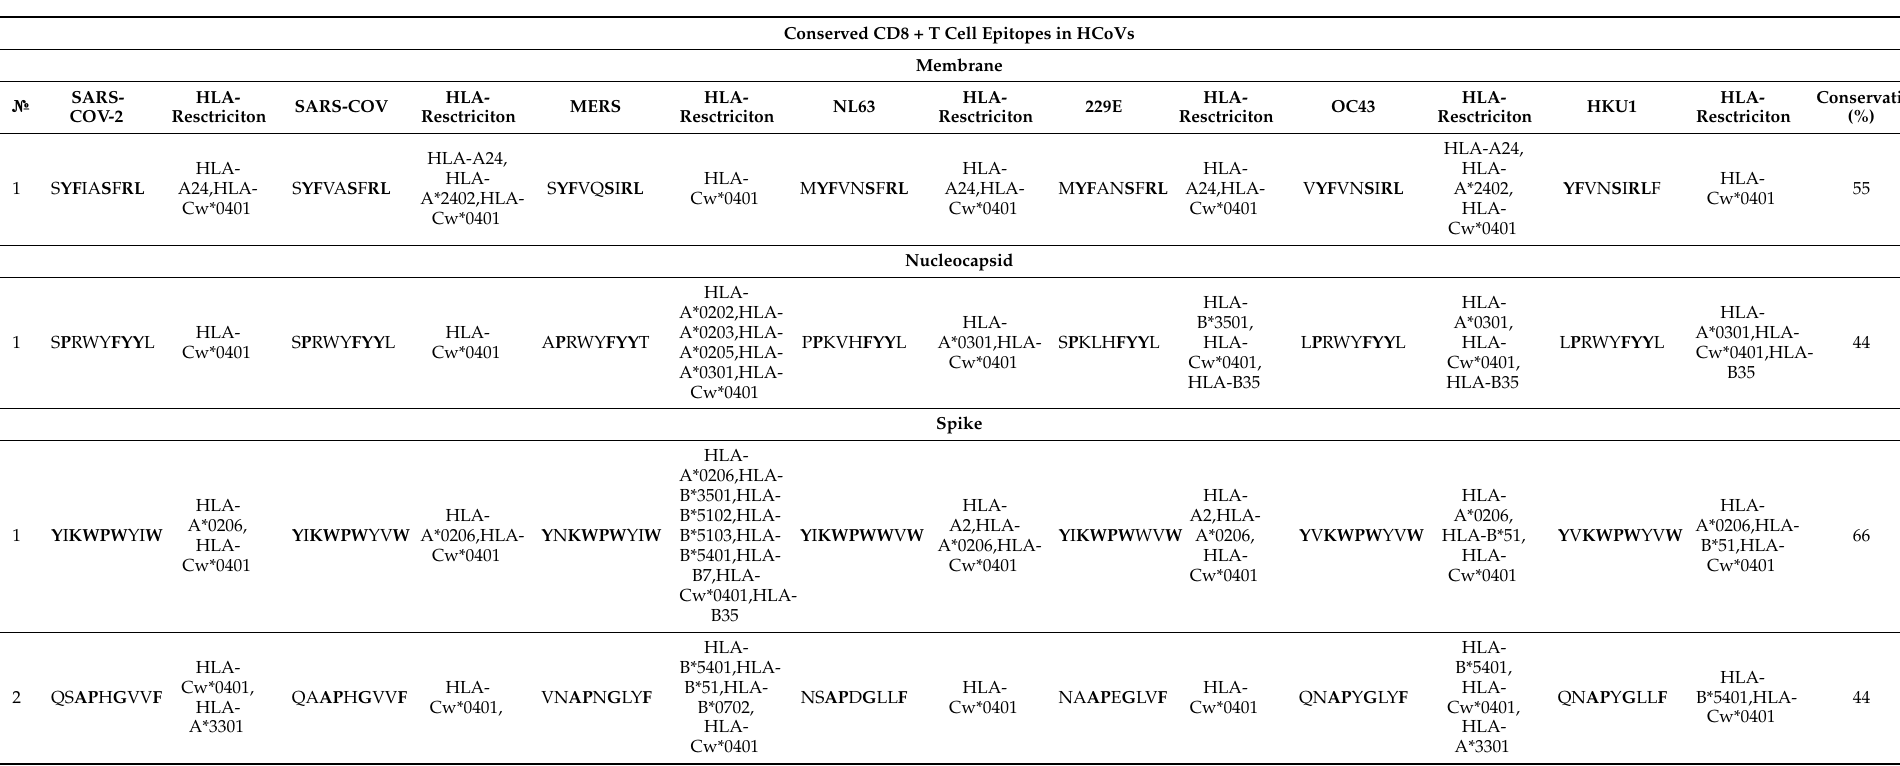
Table 2. Predicted CD8+ T cell epitopes found to be conserved in the seven HCoVs. Conserved amino acids are shown in bold letters. HLA restriction for each epitope is also given. Conserved CD8 + T Cell Epitopes in